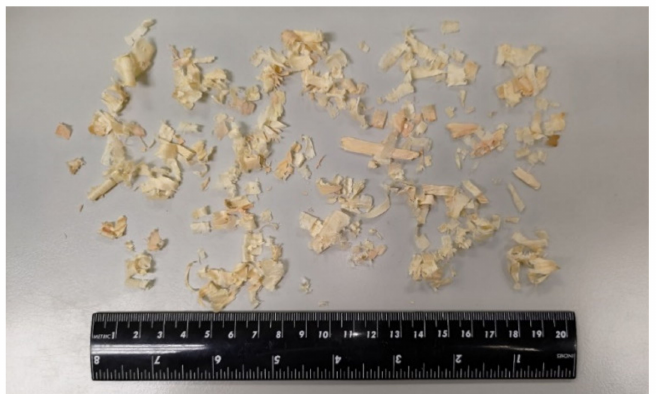
Figure 4. The shape and dimension of wood shavings regarded as artificial